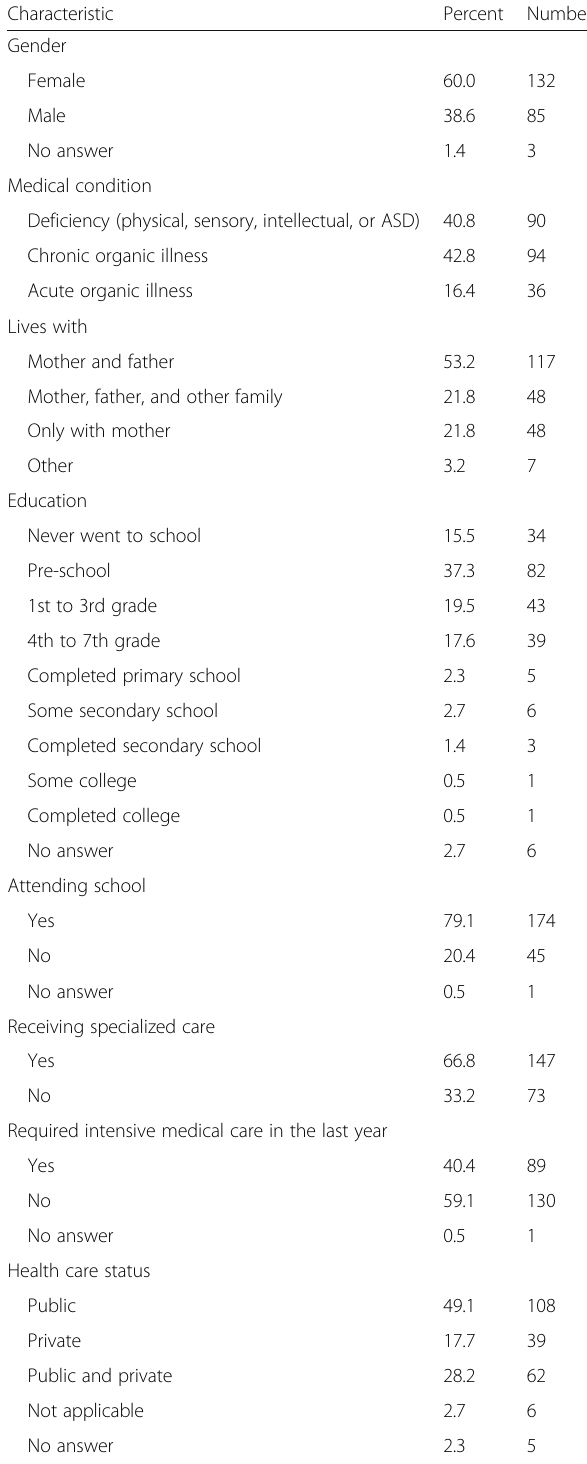
Table 2 Sociodemographic characteristics and development of the children with health problems ( n =